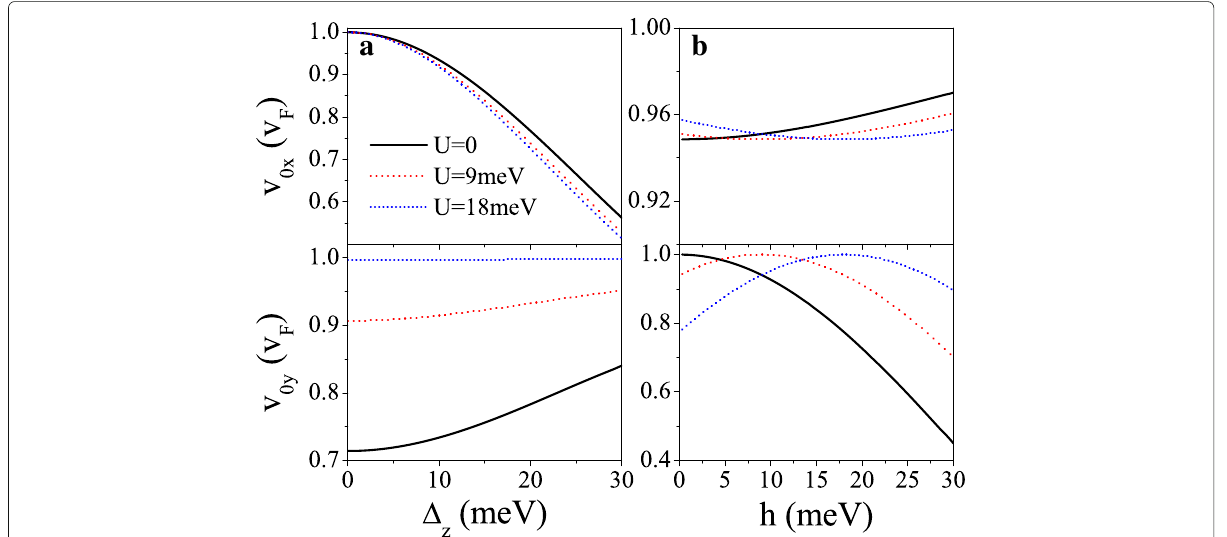
Fig. 6 Velocities v 0 x and v 0 y versus ( a ) (cid:2) z and ( b ) h , for K ↑ electron. ( a ) h = 20.0 meV and λ SO = (cid:2) z / 2. ( b ) (cid:2) z = 7.8 meV